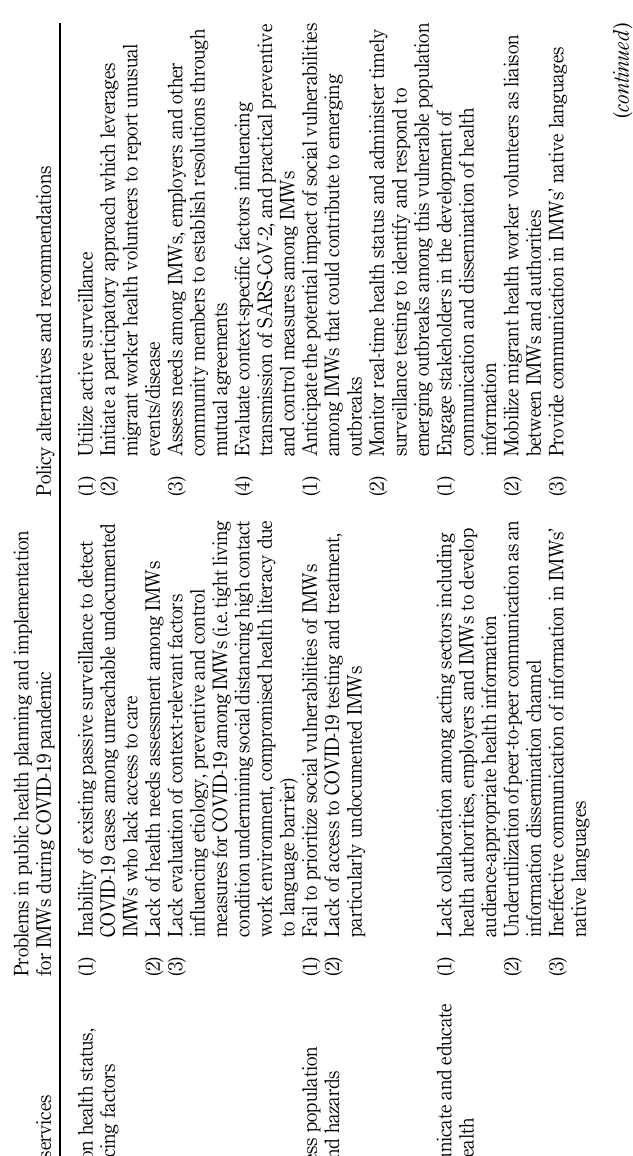
Table 1. Essential public